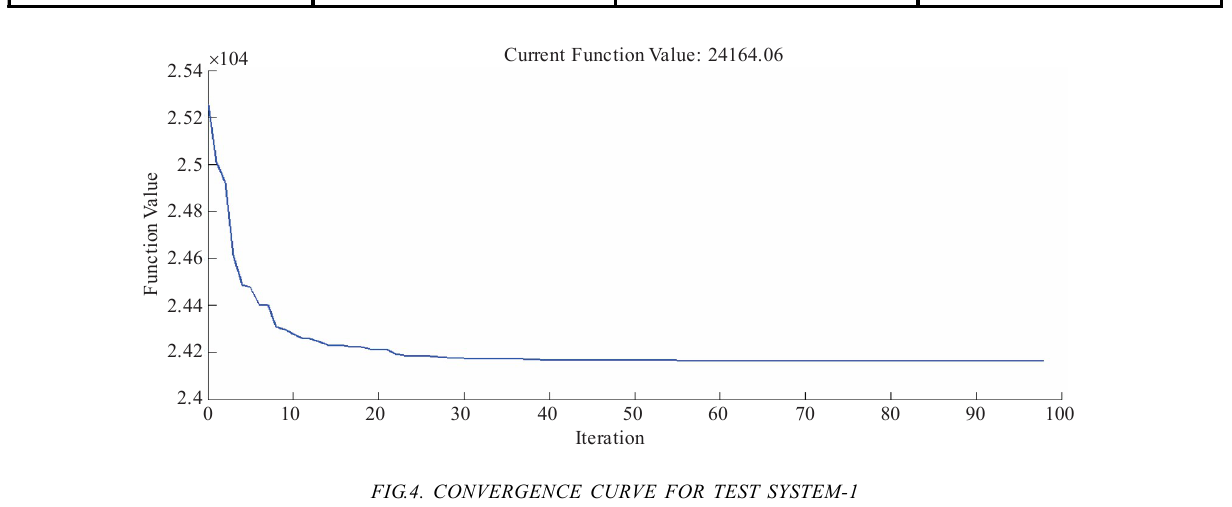
FIG.4. CONVERGENCE CURVE FOR TEST SYSTEM-1